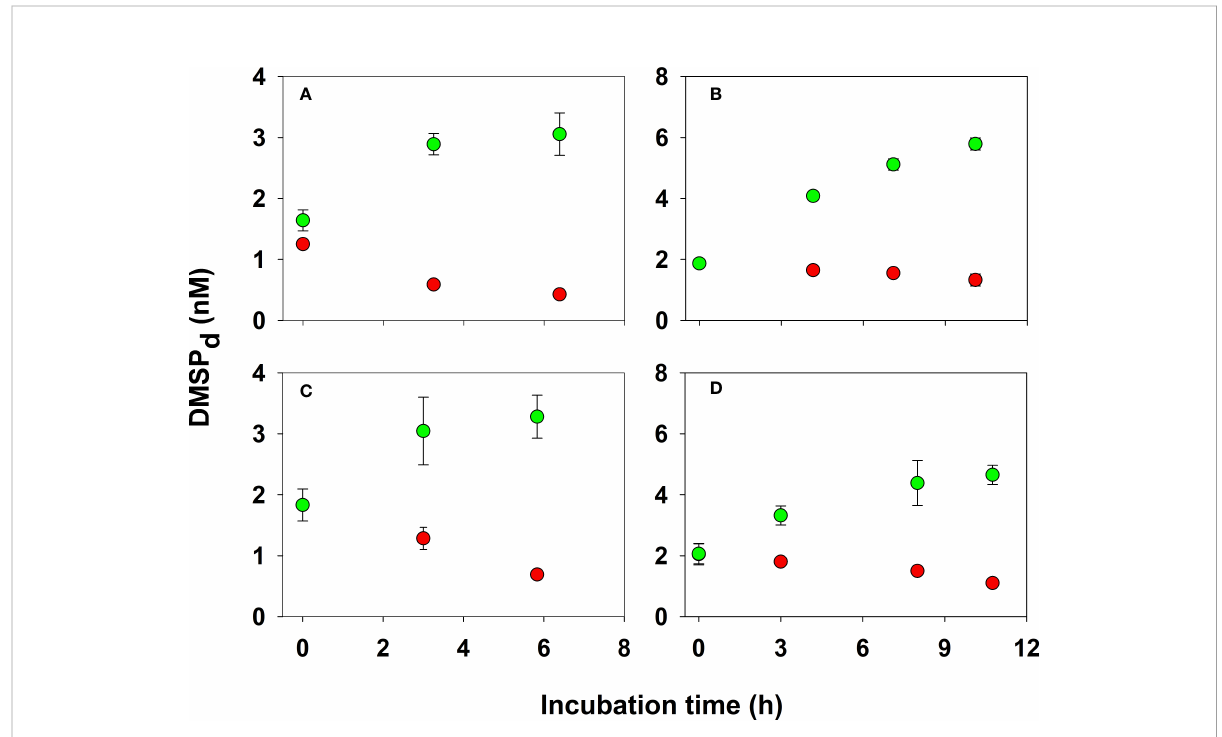
FIGURE 9 Time-course changes in the concentration of DMSP d in un fi ltered seawater from the coral reef (panels A , C ) and open ocean (panels B , D ) incubated in the dark with (green circles) and without (red circles) added GBT ( fi nal concentration, 10 µM). Data points denote the mean of triplicate incubations with error bars showing the standard deviation; errors smaller than the symbol are not